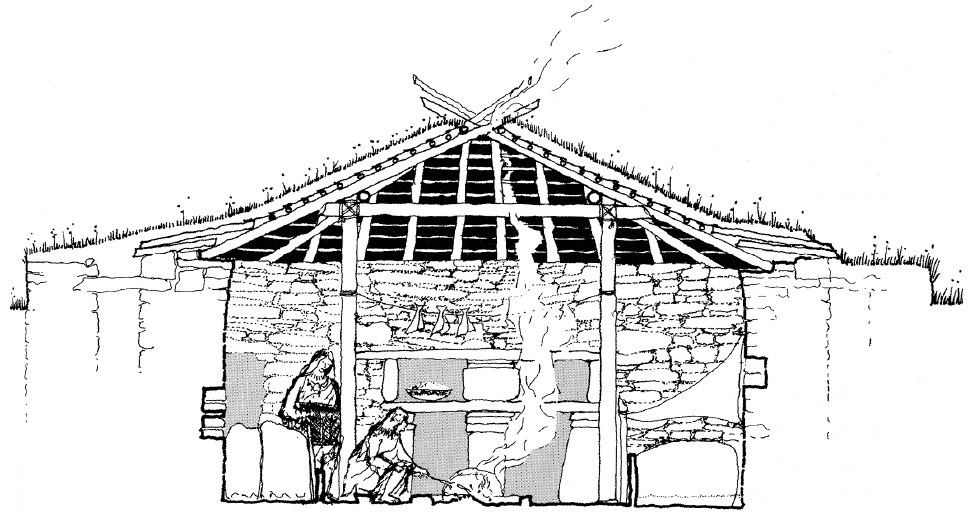
Figure 10. Sectional Reconstruction of Dwelling at Skara Brae, Trevor Garnham [44]. Photo: courtesy Trevor Garnham.